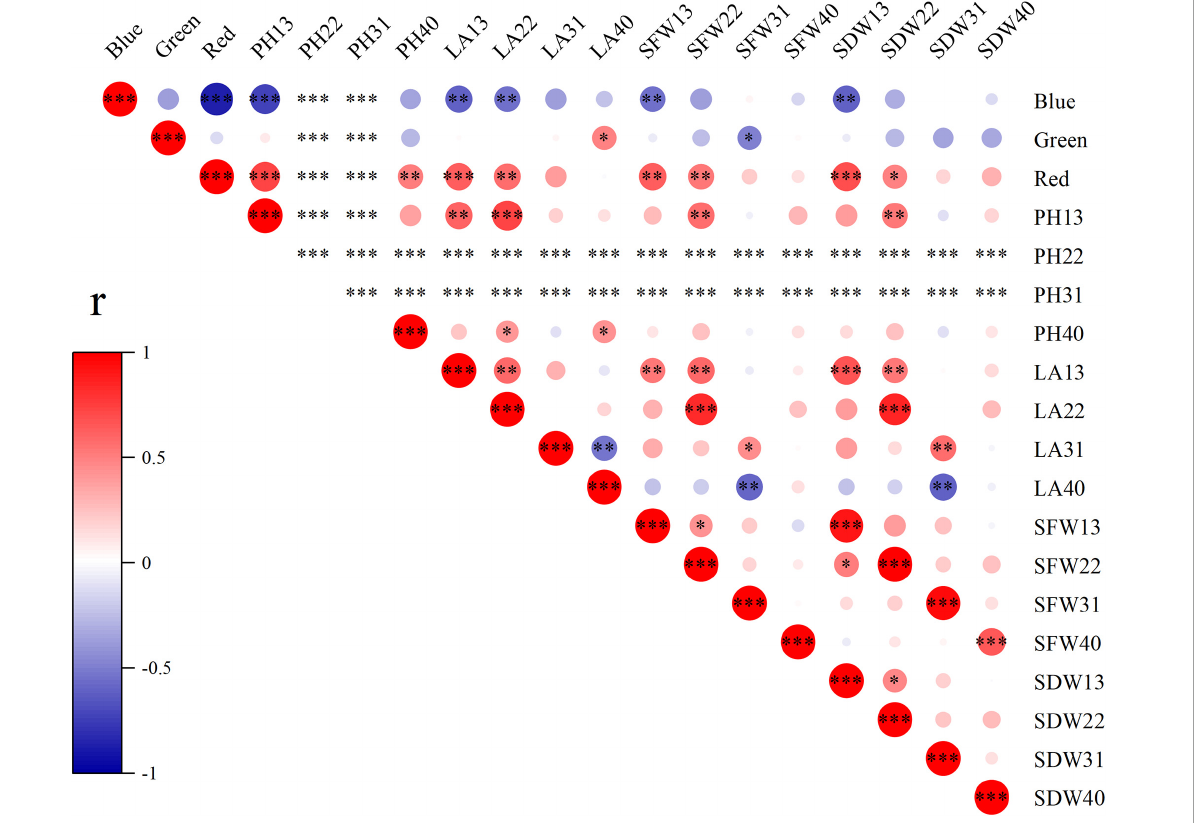
FIGURE8 The correlation among light spectral quality (blue, green, and red) and growth indicators. PH, plant height; LA, leaf area; SFW, shoot fresh weight; SDW, shoot dry weight. Difference test at the ∗ P < 0.05, ∗∗ P < 0.01, and ∗∗∗ P < 0.001 level. The colors reflect the changes in correlation coefficient: red color represents correlation coefficient with high and positive correlation and blue indicates high and negative